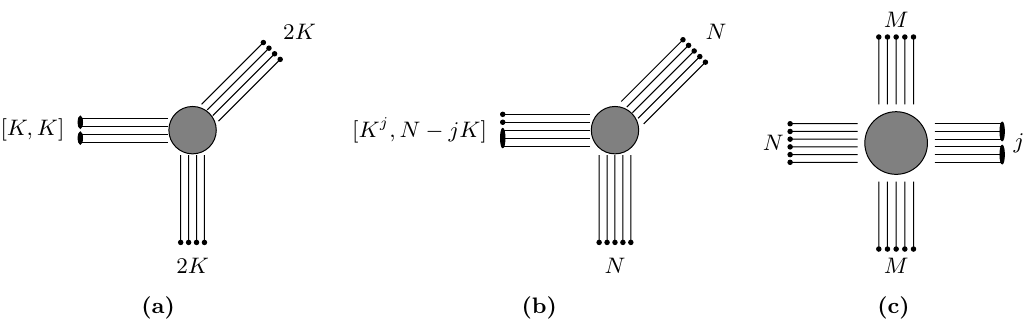
Figure 4 . Constrained 5-brane junctions with multiple 5-branes ending on the same 7-branes. From left to right for the T 2 K;K; 2 , T N;K;j , and + N;M;j